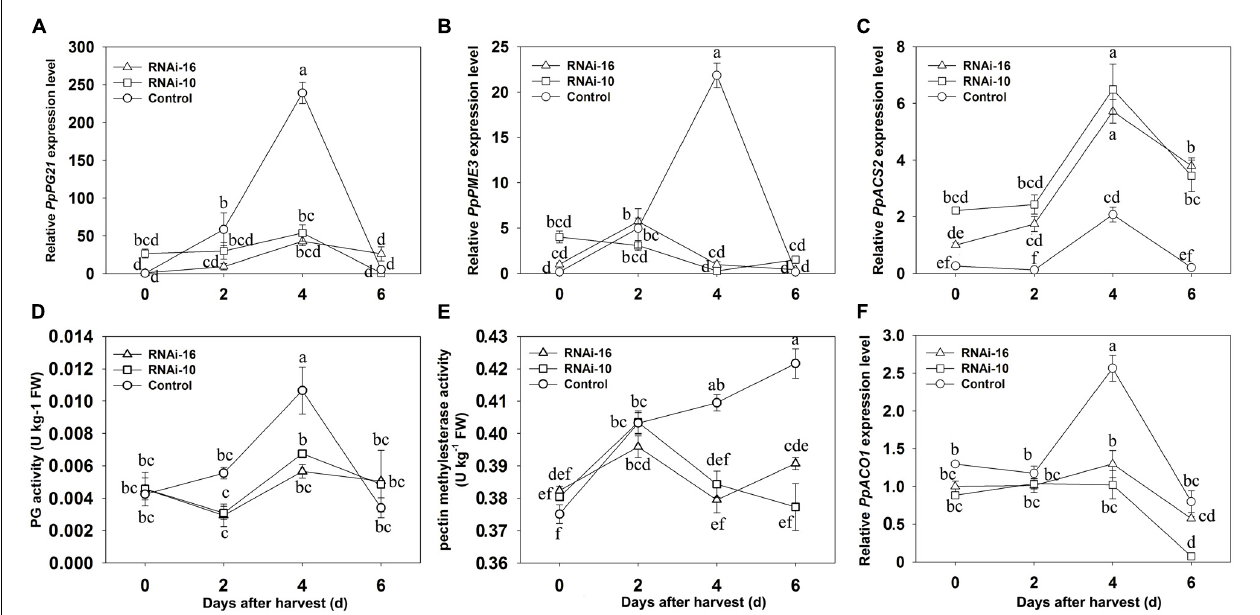
FIGURE 6 | Changes in softening-related gene expression and cell wall hydrolase activity in control, RNAi-10, and RNAi-16 fruit during storage. (A) Relative expression of PpPG21 ; (B) relative expression of PpPME3 ; (C) relative expression of PpACS2 ; (D) polygalacturonase activity; (E) pectin methylesterase activity; and (F) relative expression of PpACO1 . Each experiment was repeated three times. Data represent the mean ± SE ( n = 3). Significant differences ( p < 0.05) between means are indicated by different